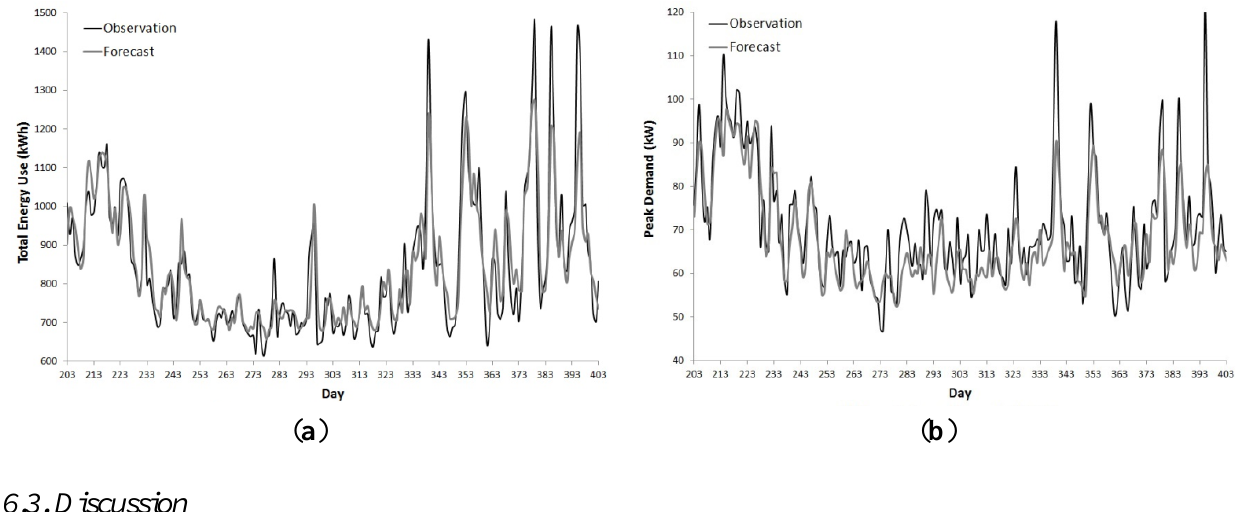
Figure 6. Phase 3’s ( a ) NN NDTEU and ( b ) NN NDPD